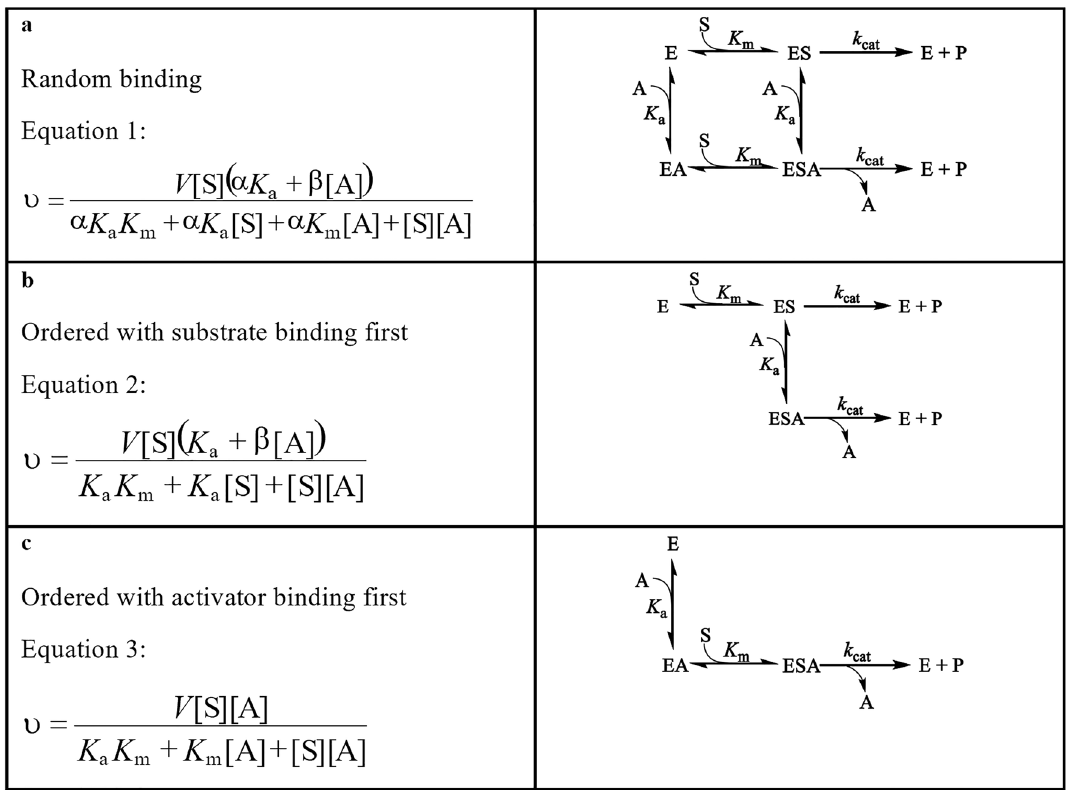
Figure 2. Kinetic mechanisms of enzyme activation. In these kinetic schemes, the symbols represent: E, enzyme, S, substrate, A, activator, K m , Michaelis-Menton constant, K a , activation constant, α, the coefficient of interaction between activator and substrate, and β, factor of k cat activation. Equations that describe these mechanisms of random binding, ordered with substrate binding first, and ordered with activator binding first are also provided where V is the maximal initial rate (k cat Et, in which Et is the total enzyme concentration). Further details are found in the Supplementary Table